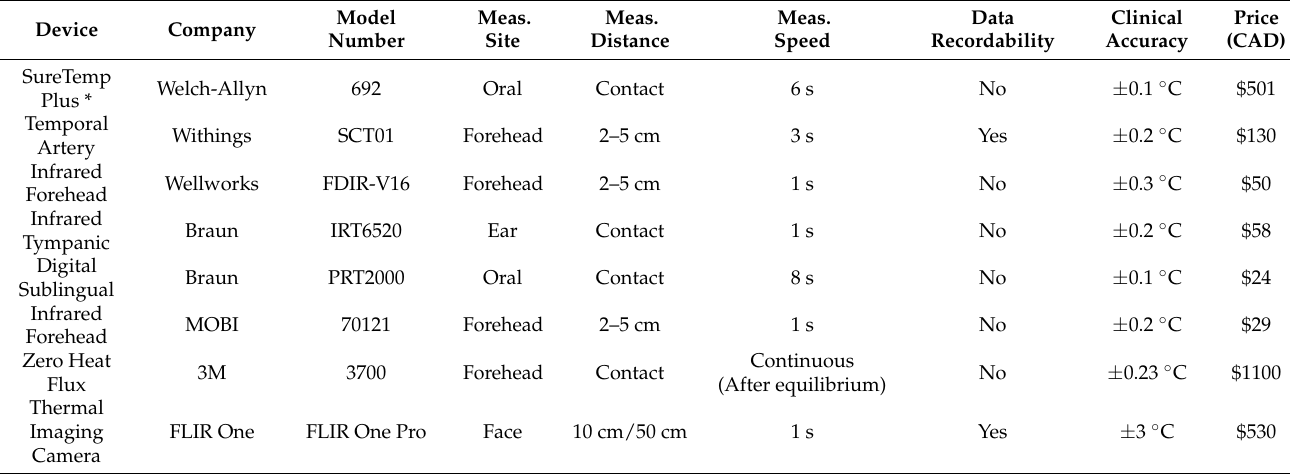
Figure 1. Selected thermometry devices. Left to right: Welch-Allyn digital sublingual, Wellworks infrared forehead, Braun infrared tympanic, MOBI infrared forehead, Withings temporal artery, Braun digital sublingual, 3M zero heat flux, FLIR One thermal imaging camera. Table 1. Characteristics of selected thermometry